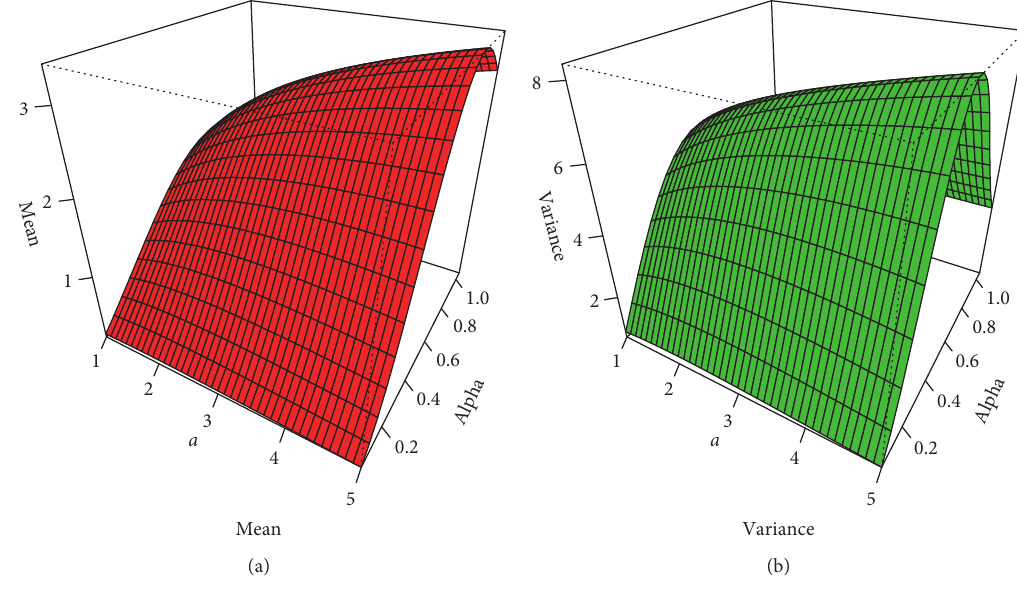
Figure 3: The mean and variance plots of the ASE-W model.